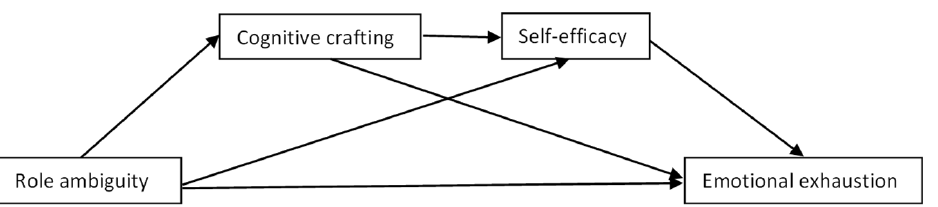
Figure 3. Hypothetical chain mediation model 3 (serial mediators: cognitive crafting and self- efficacy).